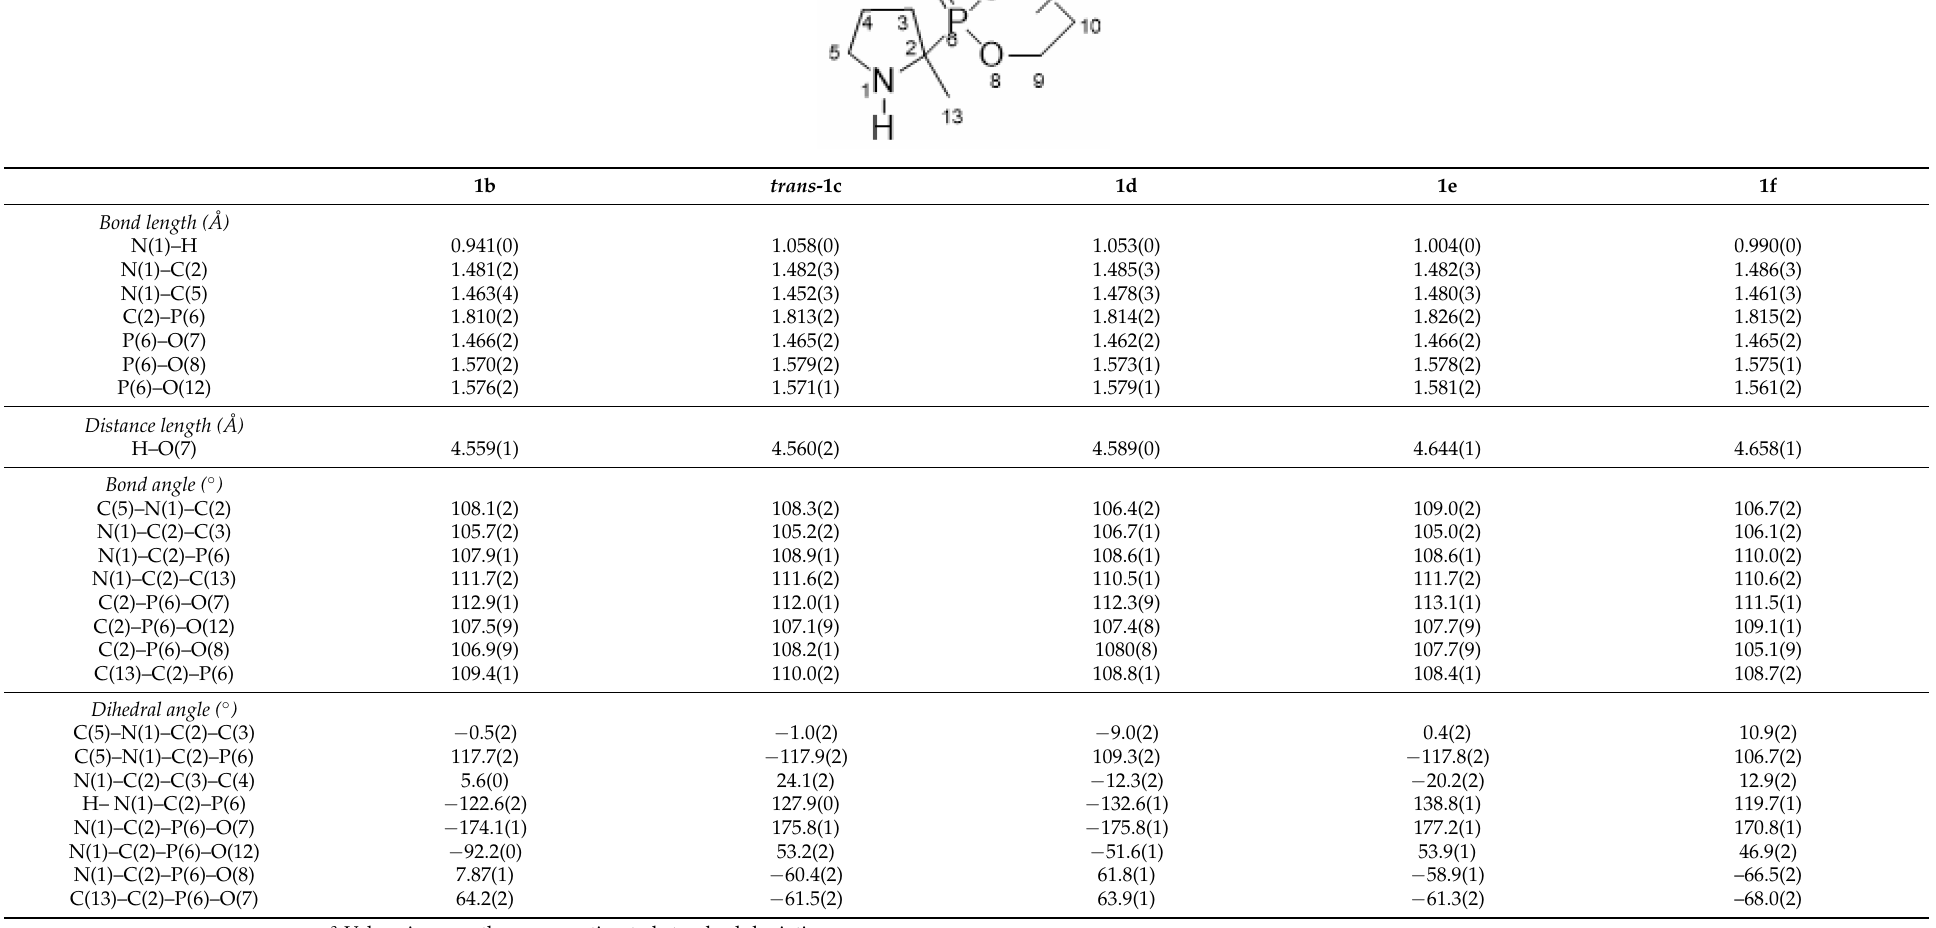
Table 1. General Structure, Atoms Numbering and Selected X-Ray Crystallographic Data of CyDEPMPHs a